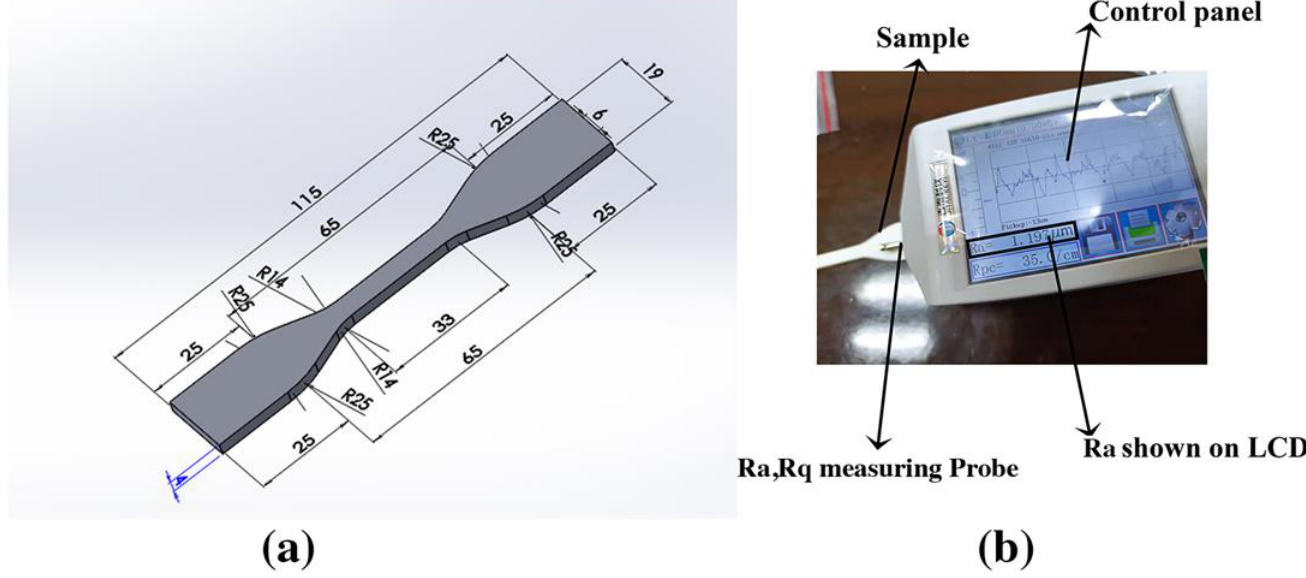
Figure 2. ( a ) STL D638 type iv sample with height 4 mm, length 115 mm, and width 19 mm; ( b ) JD 520 Ra tester.